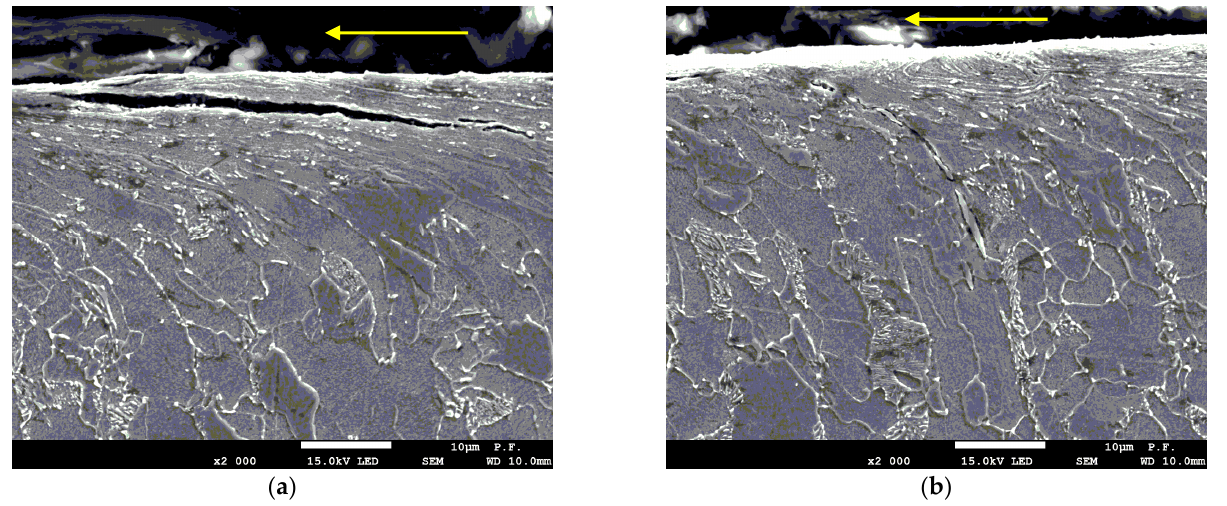
Figure 11. Cracks ( a ) parallel and ( b ) perpendicular to the line of cut (a pressure of 340 MPa and a cutting speed of 300 mm/min).